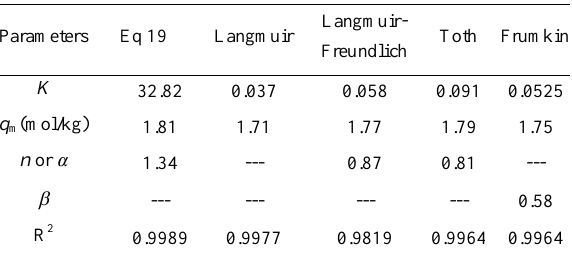
Table 3. The obtained parameters of isotherms for C adsorption on zeolite 13x at 323.15 K.